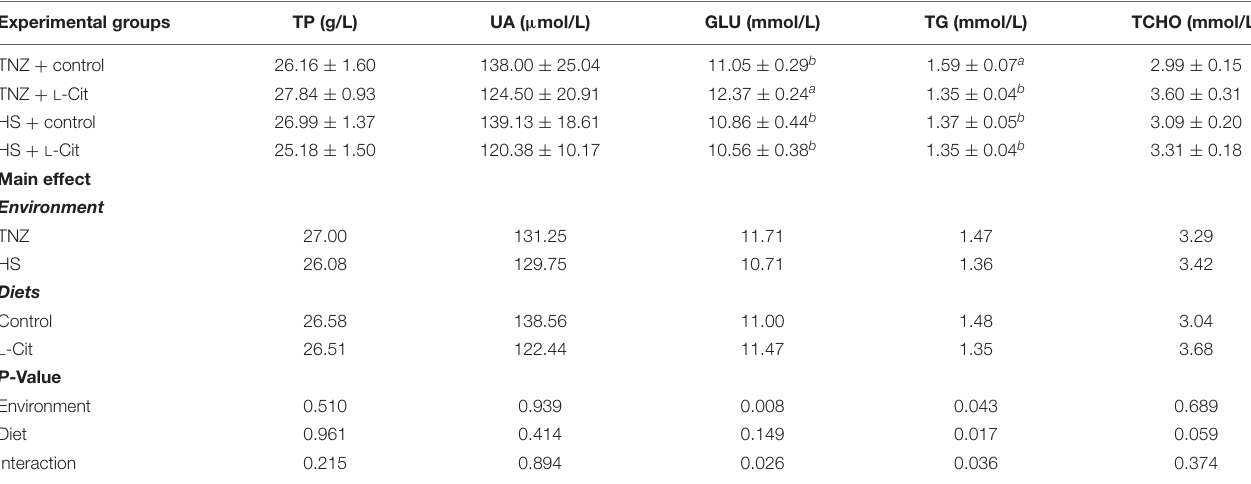
TABLE 4 | Effect of heat stress and L -citrulline supplementation on plasma metabolites of broiler chickens. Experimental